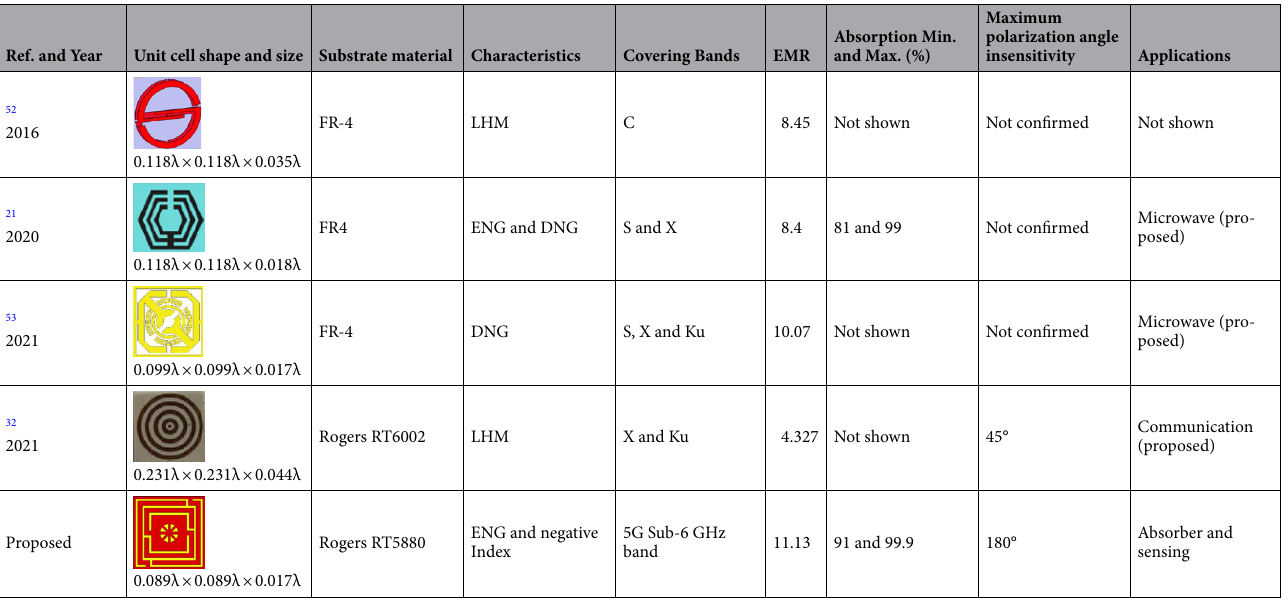
Table 3. Compare and contrast the proposed MM structure with existing relevant